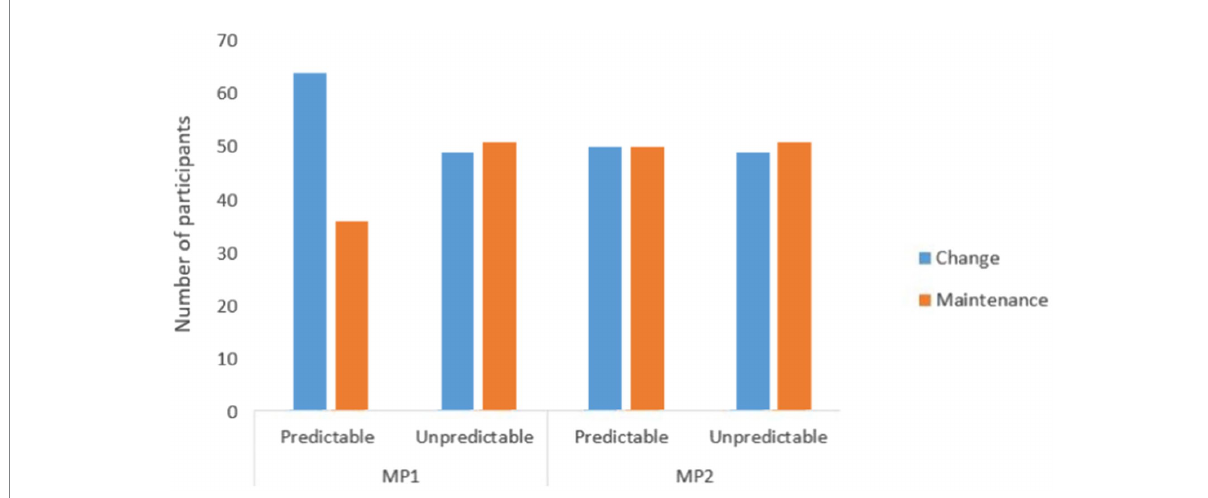
FIGURE 4 Evolution of goal change after introduction of an environmental constraint, depending on the measurement point and the predictability of the